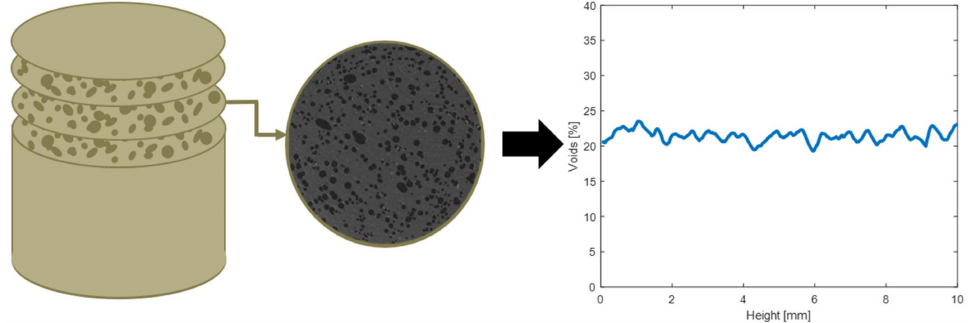
Figure 5. Depicts the workflow for the MATLAB program for quantifying the quantity of voids present within the